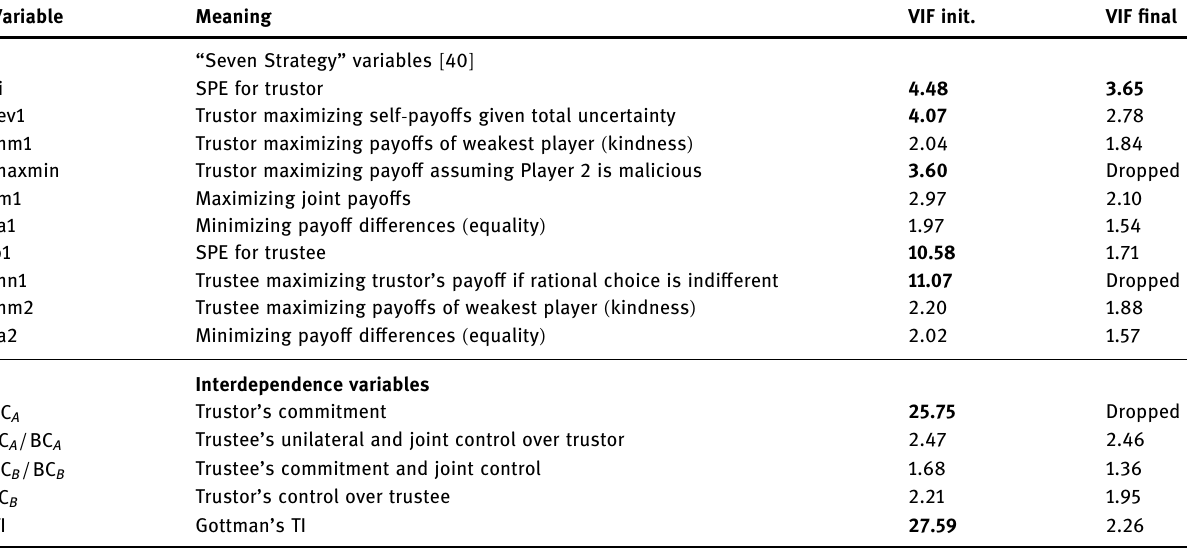
Table 3: Seven strategies and interdependence variables and their initial and fi nal VIF, after strong multicollinear variables were dropped